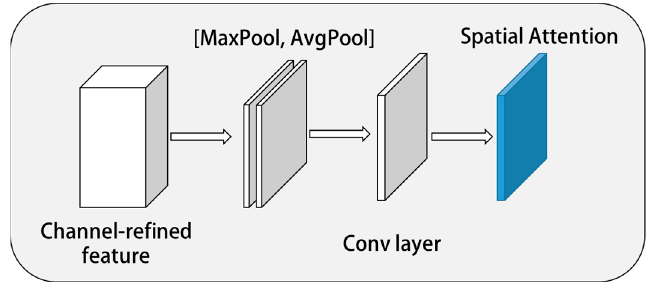
Figure 6. Spatial attention module.